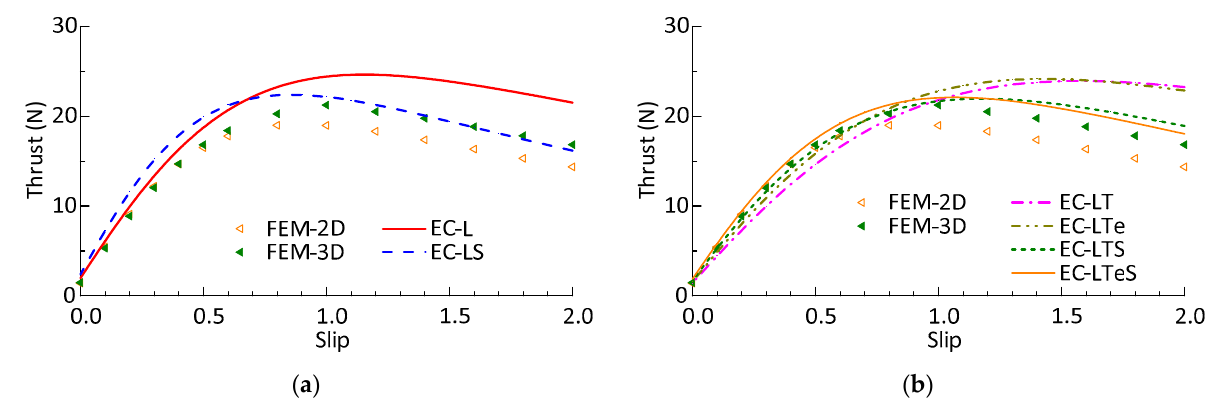
Figure 9. Thrust versus slip characteristics with a mechanical gap of 0.0135 m: ( a ) is calculated by equivalent circuit EC-L, EC-LS, FEM 2D, and FEM 3D model; ( b ) is calculated by equivalent circuit EC-LT, EC-LTe, EC-LTS, EC-LTeS, FEM 2D, and 3D model.